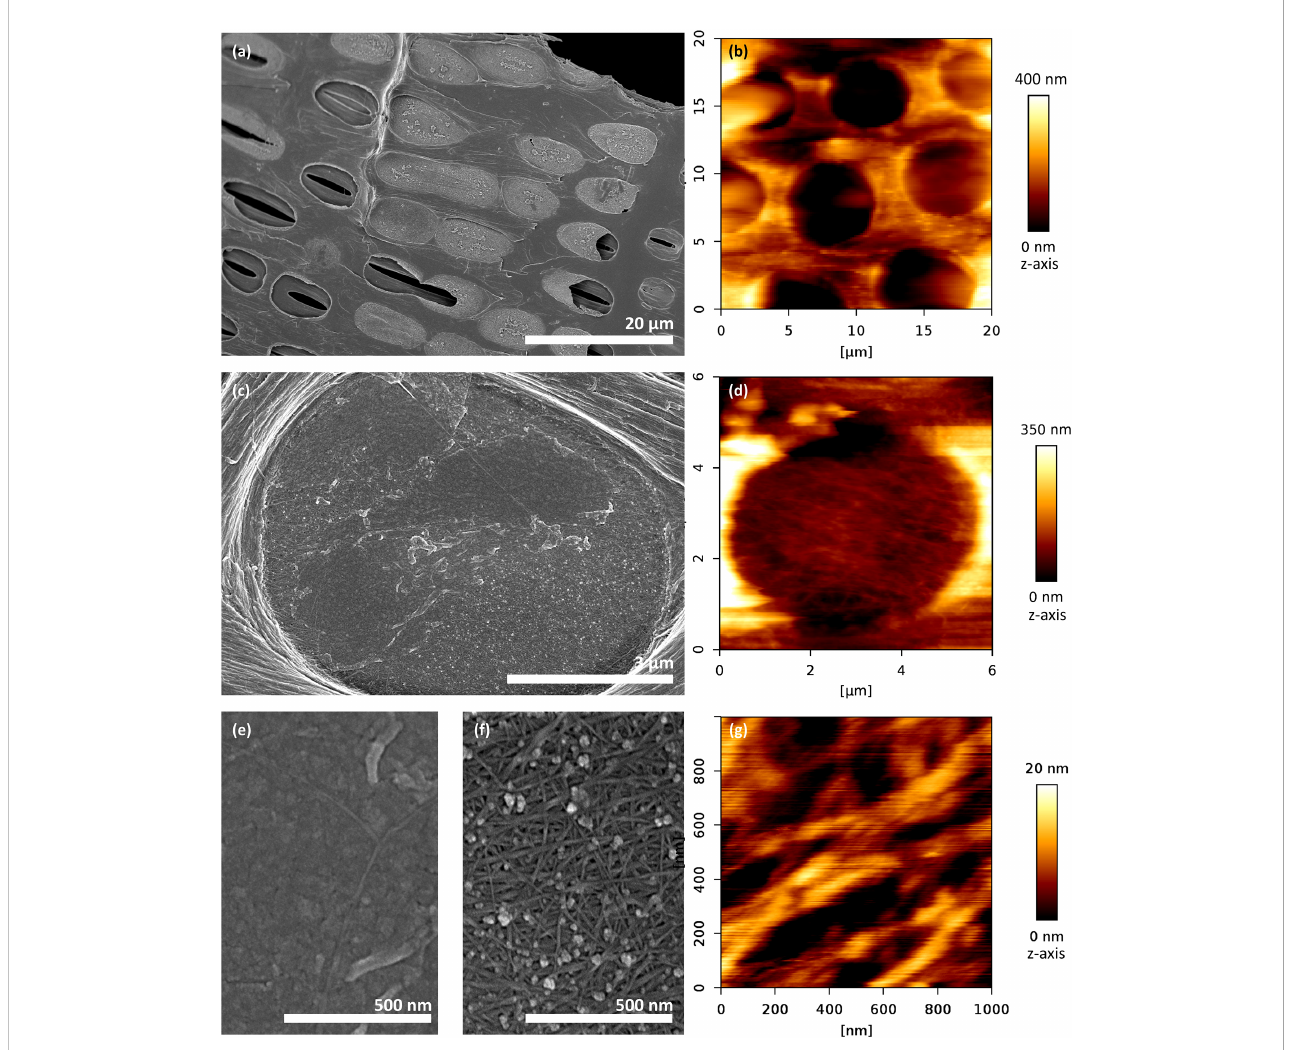
FIGURE 2 Exposed intervessel pit membranes of Clematis vitalba after removal of the overlying secondary cell wall. Left column: SEM, right column: AFM, Tapping mode. (A, B) Overview: Pit membranes were either intact (i.e., covering the entire pit border), incomplete (i.e., partly broken), or completely removed during sample preparation. (C, D) Single pit membrane, format- fi lling. (D, G) Cellulose micro fi brillar aggregates make up the main component of the pit membrane. (C, E, F) The membrane is partly covered with a non-cellulosic layer, or at least associated with micelle-like